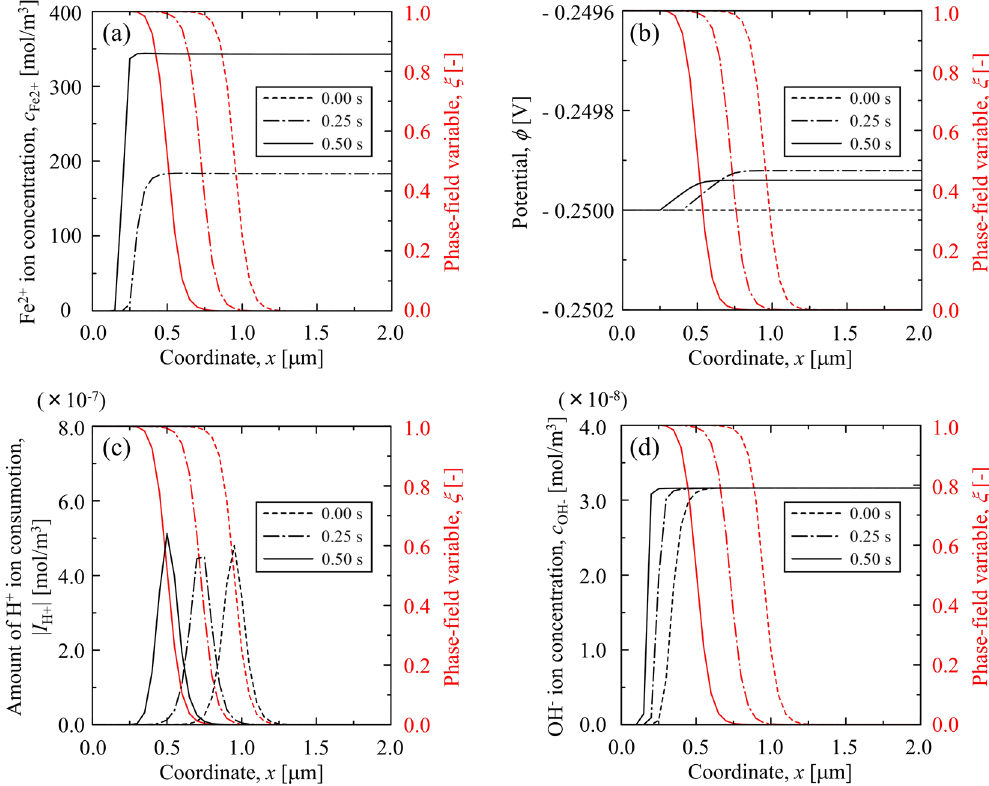
Figure 2. Evolutions of ( a ) Fe 2 + ion concentration, ( b ) electrostatic potential, ( c ) consumption of H + ion in the interface region, and ( d ) OH − ion concentration at the pH of 2.5 and 60 °C (Case #2). In each figure, the profiles of the phase field variable are inserted to indicate the migration of iron electrode surface during the general